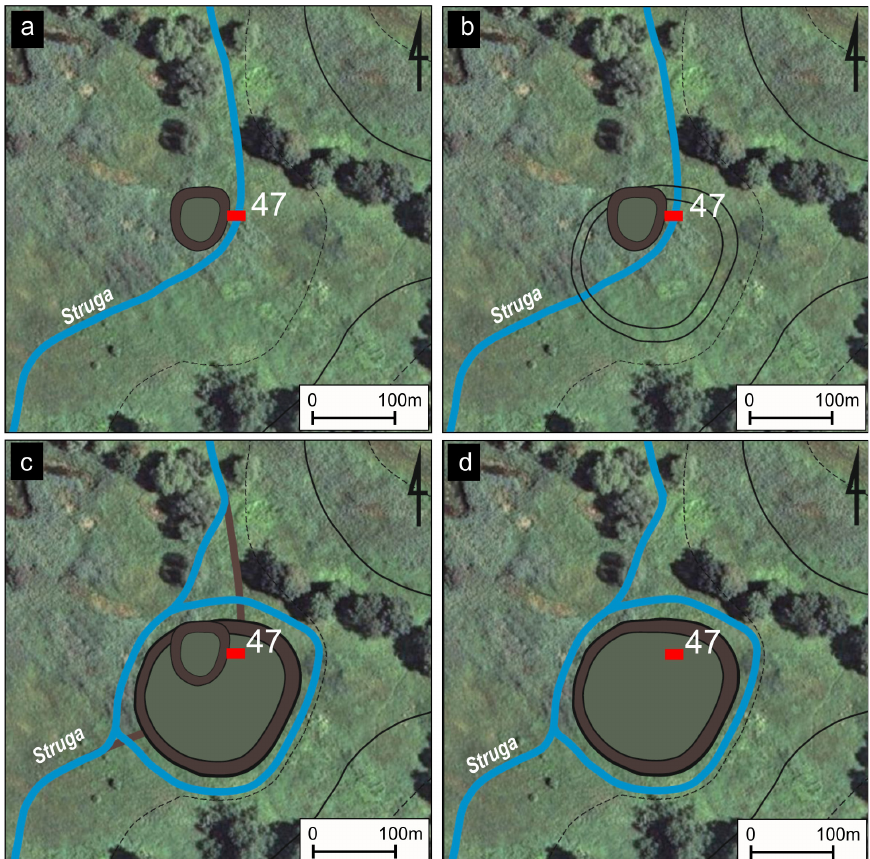
Fig. 8. Proposal of the reconstruction of subsequent stages of the change in the location of the Struga River channel based on geological research, stages of development of the stronghold according to archaeological research results (Petri 2006, Petri, Bakiewicz 2002). a) and b) the older phase of the ring fort, c) younger phase with visible marked older phase, d) the younger phase of the ring fort; archaeological excavation no. 47 marked by a red